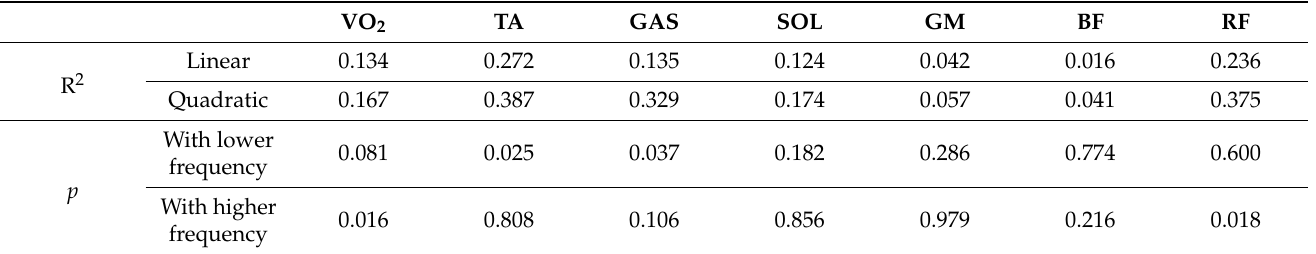
Table 3. Results of modeling analysis for muscle activity and oxygen consumption and the differences between values at the preferred and other frequencies under general